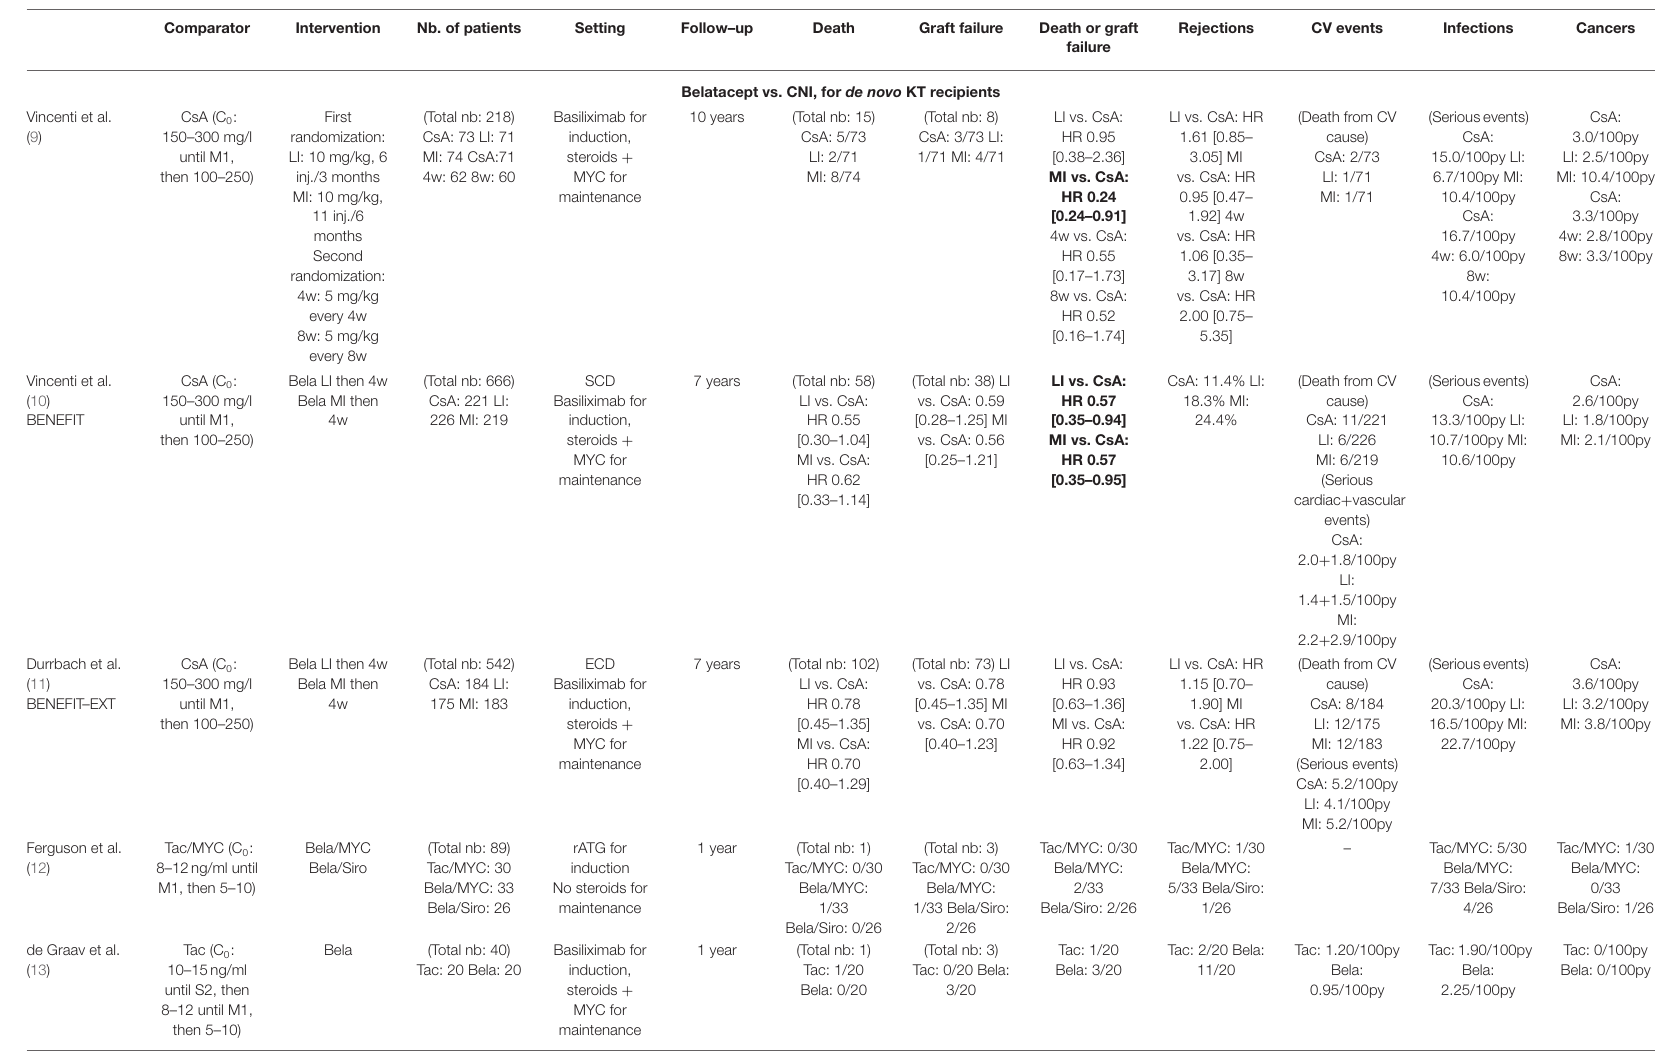
Rejections CV events Infections Cancers failure Belatacept vs. CNI, for de novo KT recipients